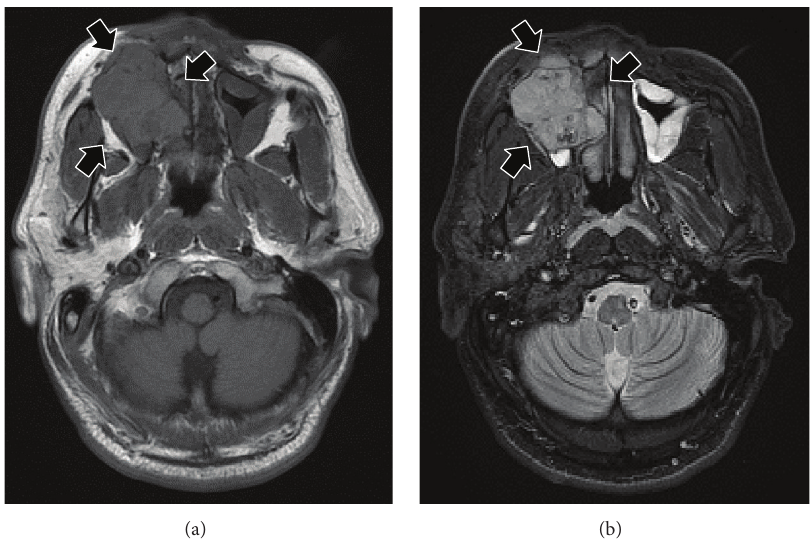
Figure 4: An MRI scan shows a mass with low T1- (a) and moderate T2-weighted (b) signal intensity.